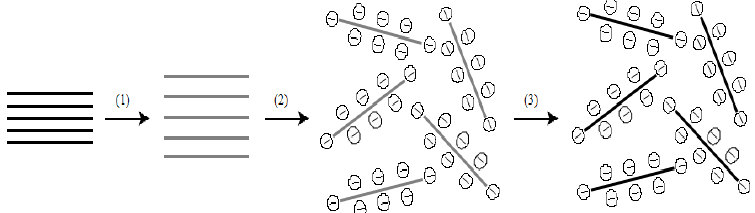
Figure 9. Schematic illustration of the synthesis of reduced graphene oxide dispersions. ( 1 ) Graphite (black blocks) is oxidized to graphite oxide (lighter colored blocks) with greater interlayer distance by a modified Hummers’ method; ( 2 ) Graphite oxide is dispersed in water with an ultra-sonication agitation to form GO colloids; and ( 3 ) GO colloids are reduced to reduced graphene oxide (RGO) by hydrazine (reprinted from Ref. [86] with permission from Nature Publishing Group).